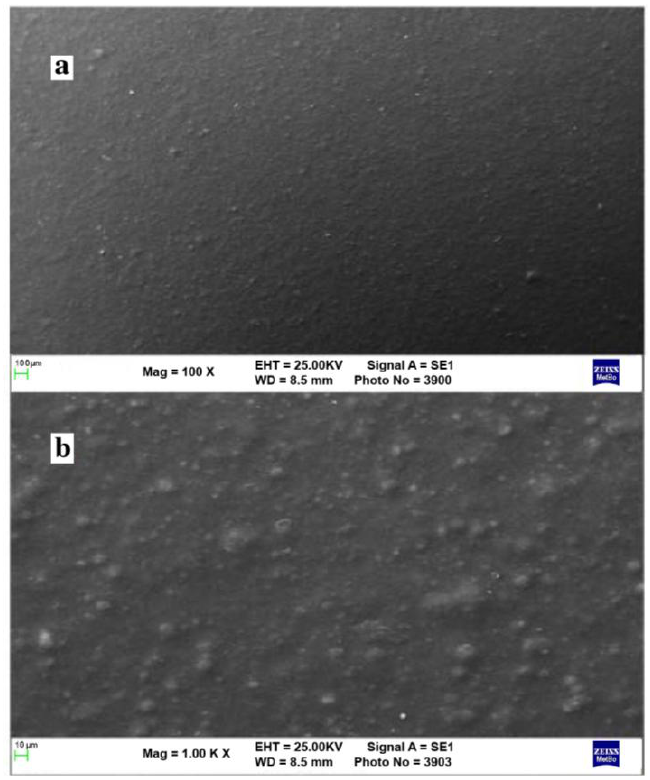
Figure 4. SEM images of the sprayed aqueous acrylic-urethane dispersion containing TiO nanocrystals at ( a ) 100×; and ( b ) 1000× magnification.